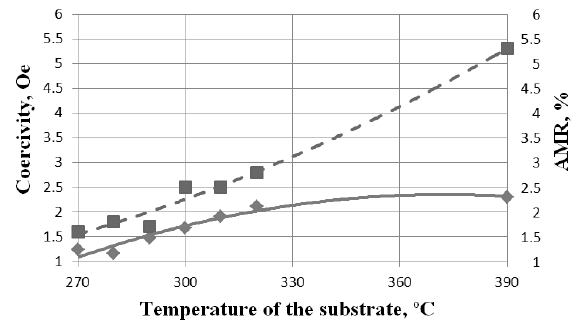
Fig. 5. The dependence of the coercivity (dashed line) and the AMR (solid line) on the substrate temperature.